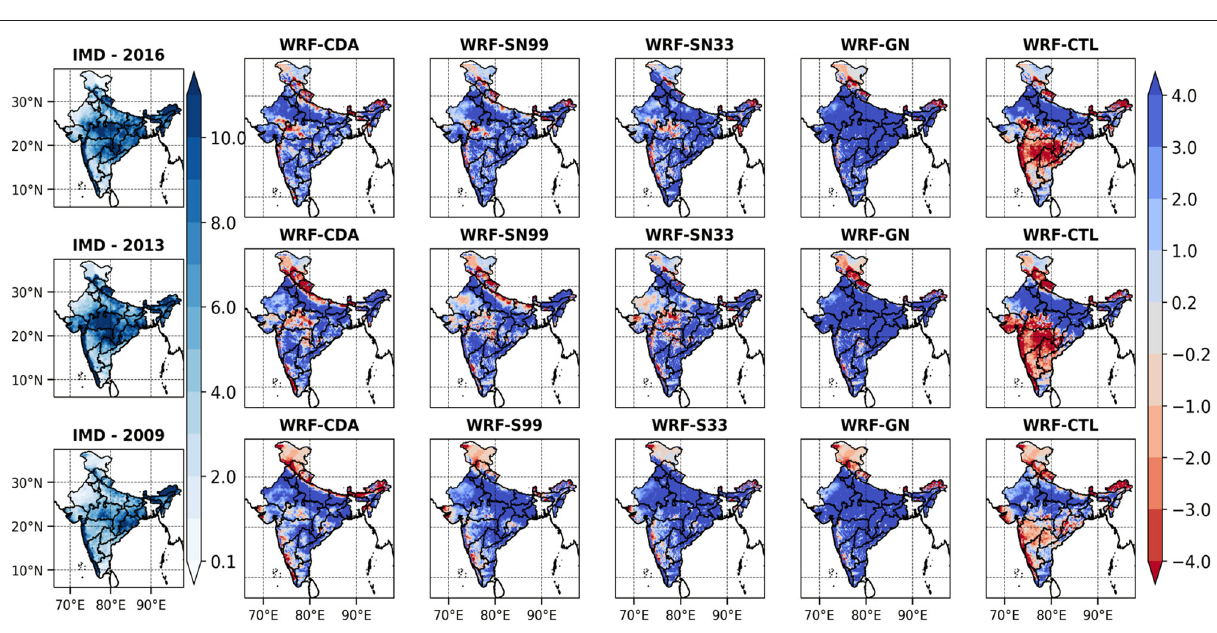
simulated by WRF-CDA, followed by WRF-SN (SN99 followed by SN77, SN55, and SN33). WRF-CDA and WRF-SN99 runs reproduce the gross rainfall distributions, but show a dry bias over central India extending to northwest India, Tibet